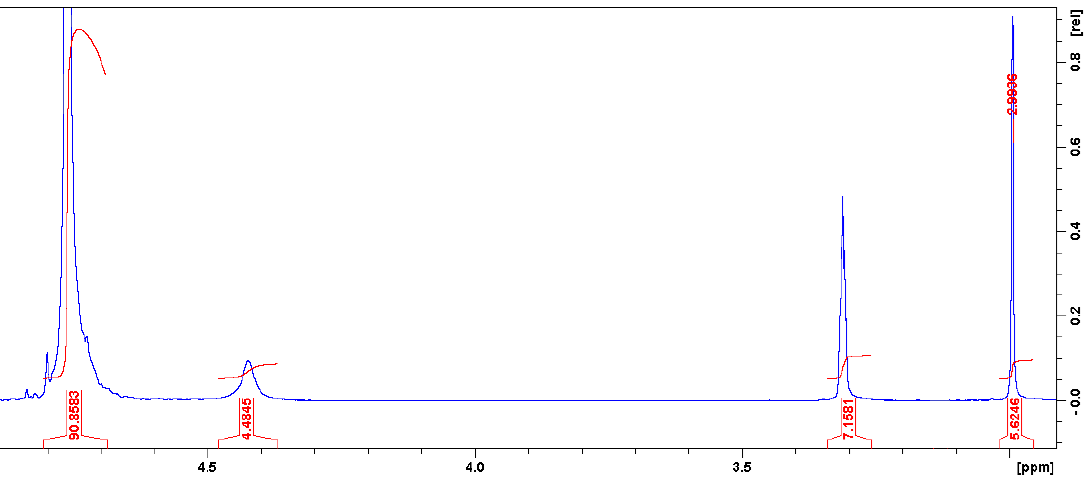
Figure 1. 1 H-NMR spectra of the 5cc.